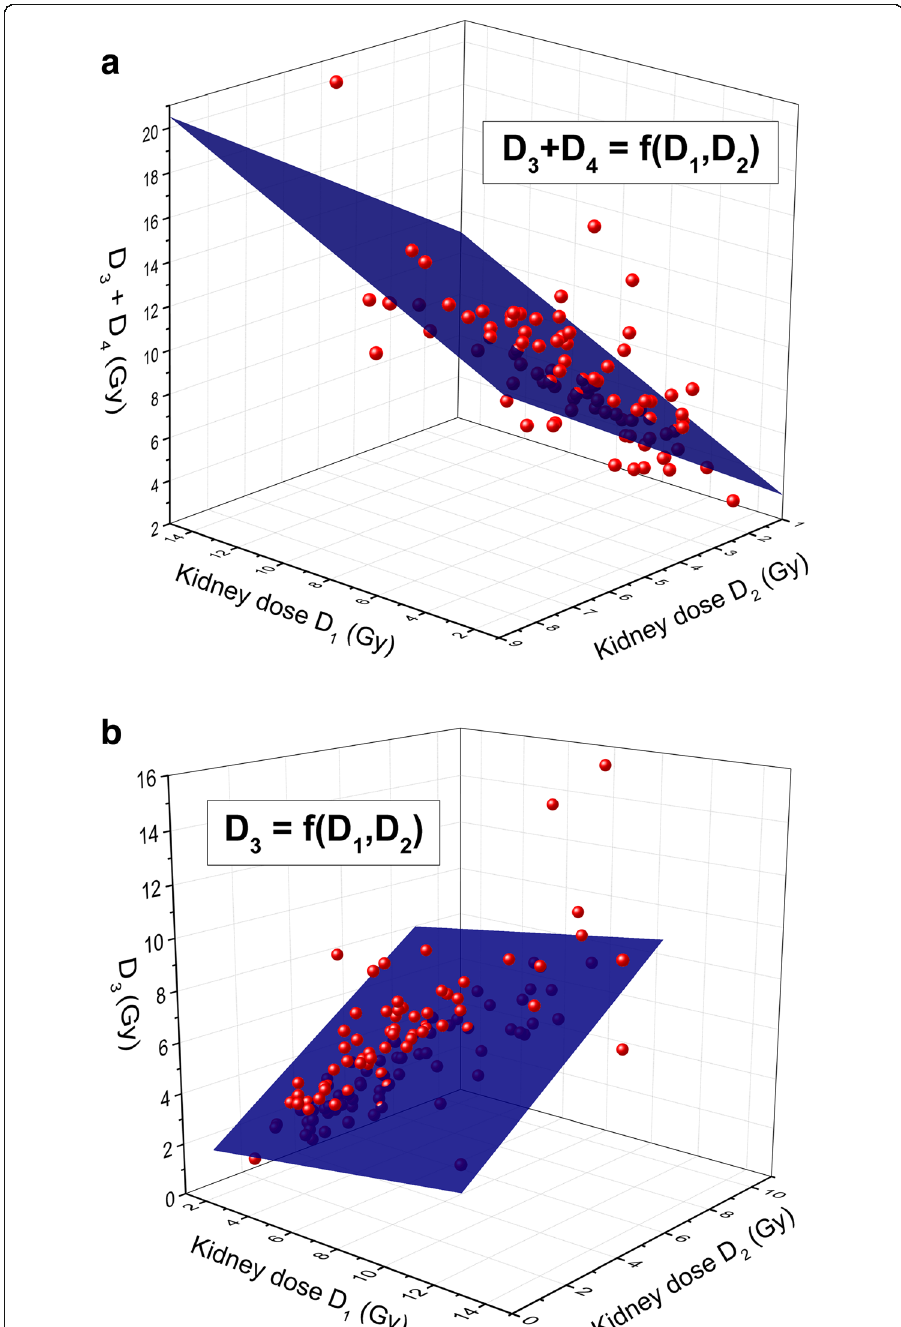
Fig. 4 Relationship between D 1 , D 2 , and D 3 + D 4 or D 3. Legend: Relationship between D 1 , D 2 and a D 3 + D 4 and b D 3 . The multilinear fits are shown (blue Relationship between D 4 and D 1 , D 2 , D 3 A multivariate linear analysis gives: ¼ a þ b (cid:2) D þ c (cid:2) D þ d (cid:2) D D 4 3 3 1 3 2 3 3 with a = 0.99, b = 0.12, c = 0.19, and d = 0.50. This model lets us predict the 3 3 3 3